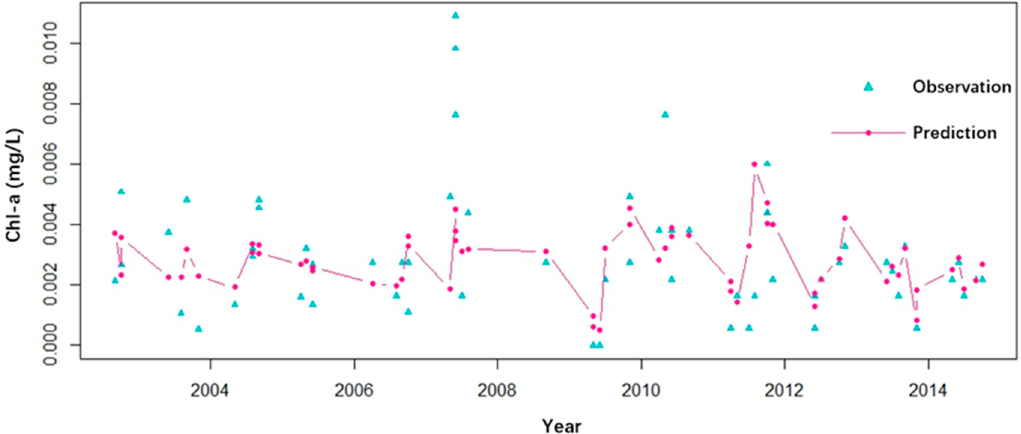
Figure 5. Prediction results of RF model in test stage.